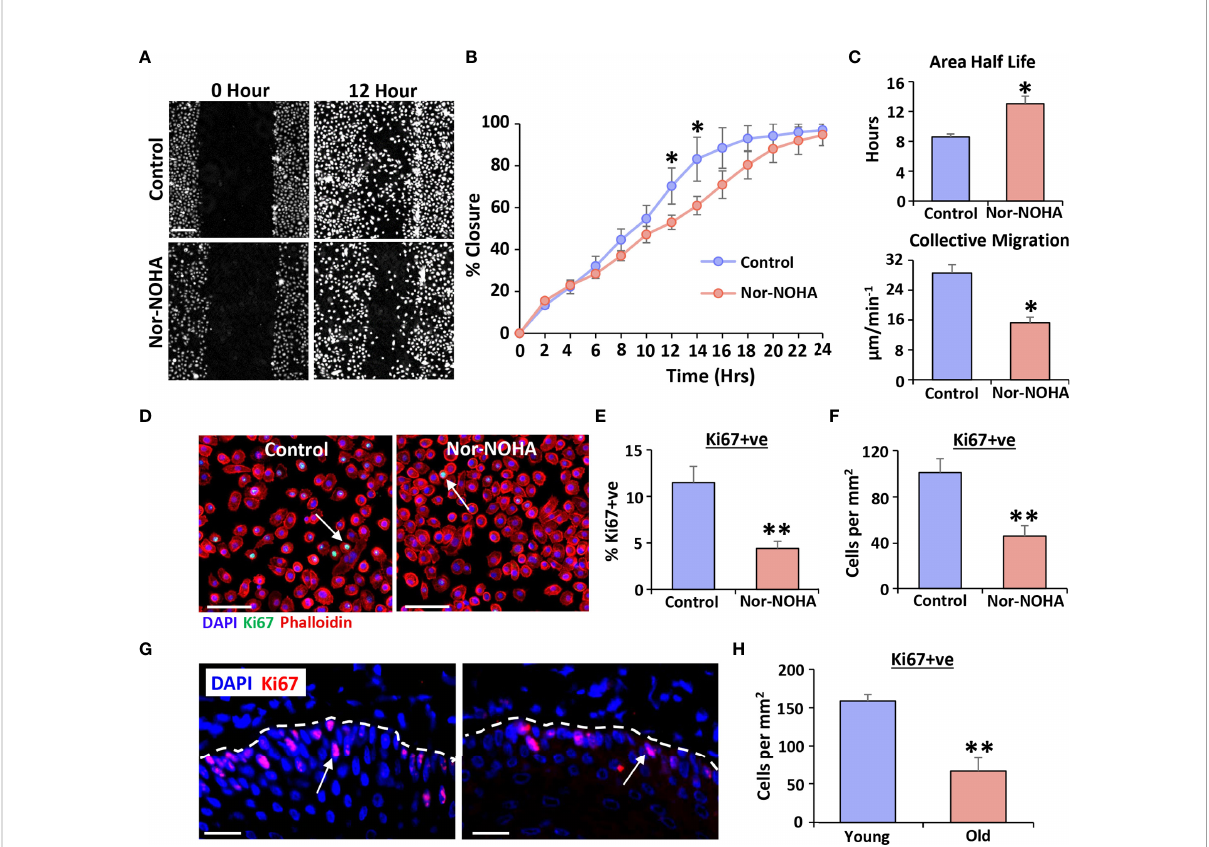
FIGURE 4 Arginase 1 inhibition delays healing in human vaginal epithelial cells and attenuates proliferation in vivo . Livecyte ptychographic imaging was performed to assess migration. Representative frames at 12 hours (A) . Bar = 100 µm. Quanti fi cation of closure over time (B) , average scratch area half-life and collective migration (C) . Ki67 staining for proliferation (D) and quanti fi cation (E, F) . Ki67 = Alexa Fluor 488. Rhodamine phalloidin = cytoskeleton. DAPI = cell nuclei. Bar = 100 µm. Ki67 staining in young and old rat vaginal epithelium at day 3 post-injury (G)